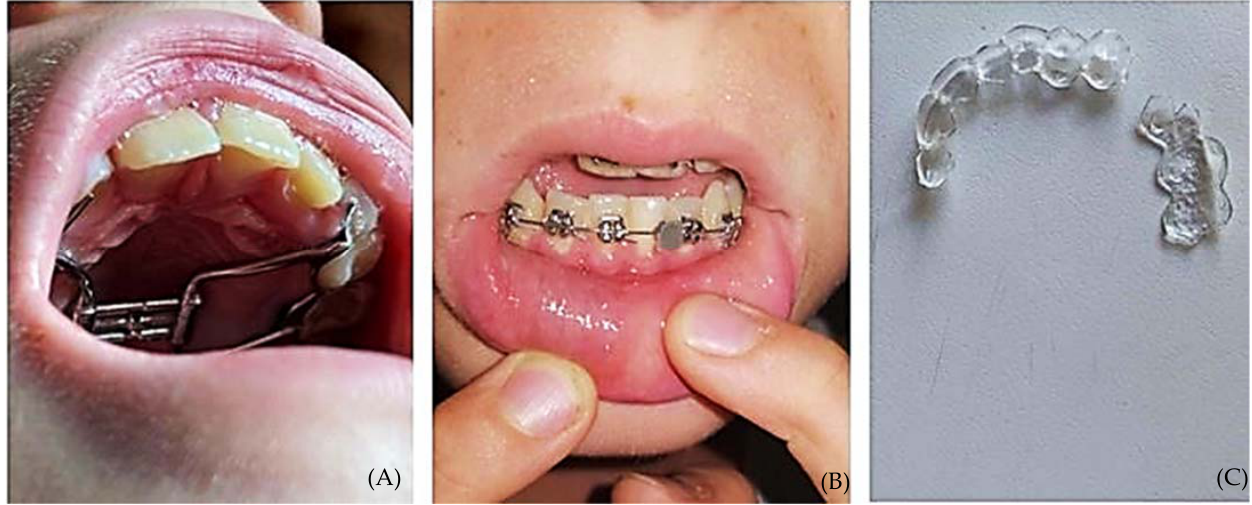
Figure 1. Problems usually reported with fixed or removable appliances: ( A ) gingival inflammation; ( B ) bracket detachment; ( C ) fractured aligners.